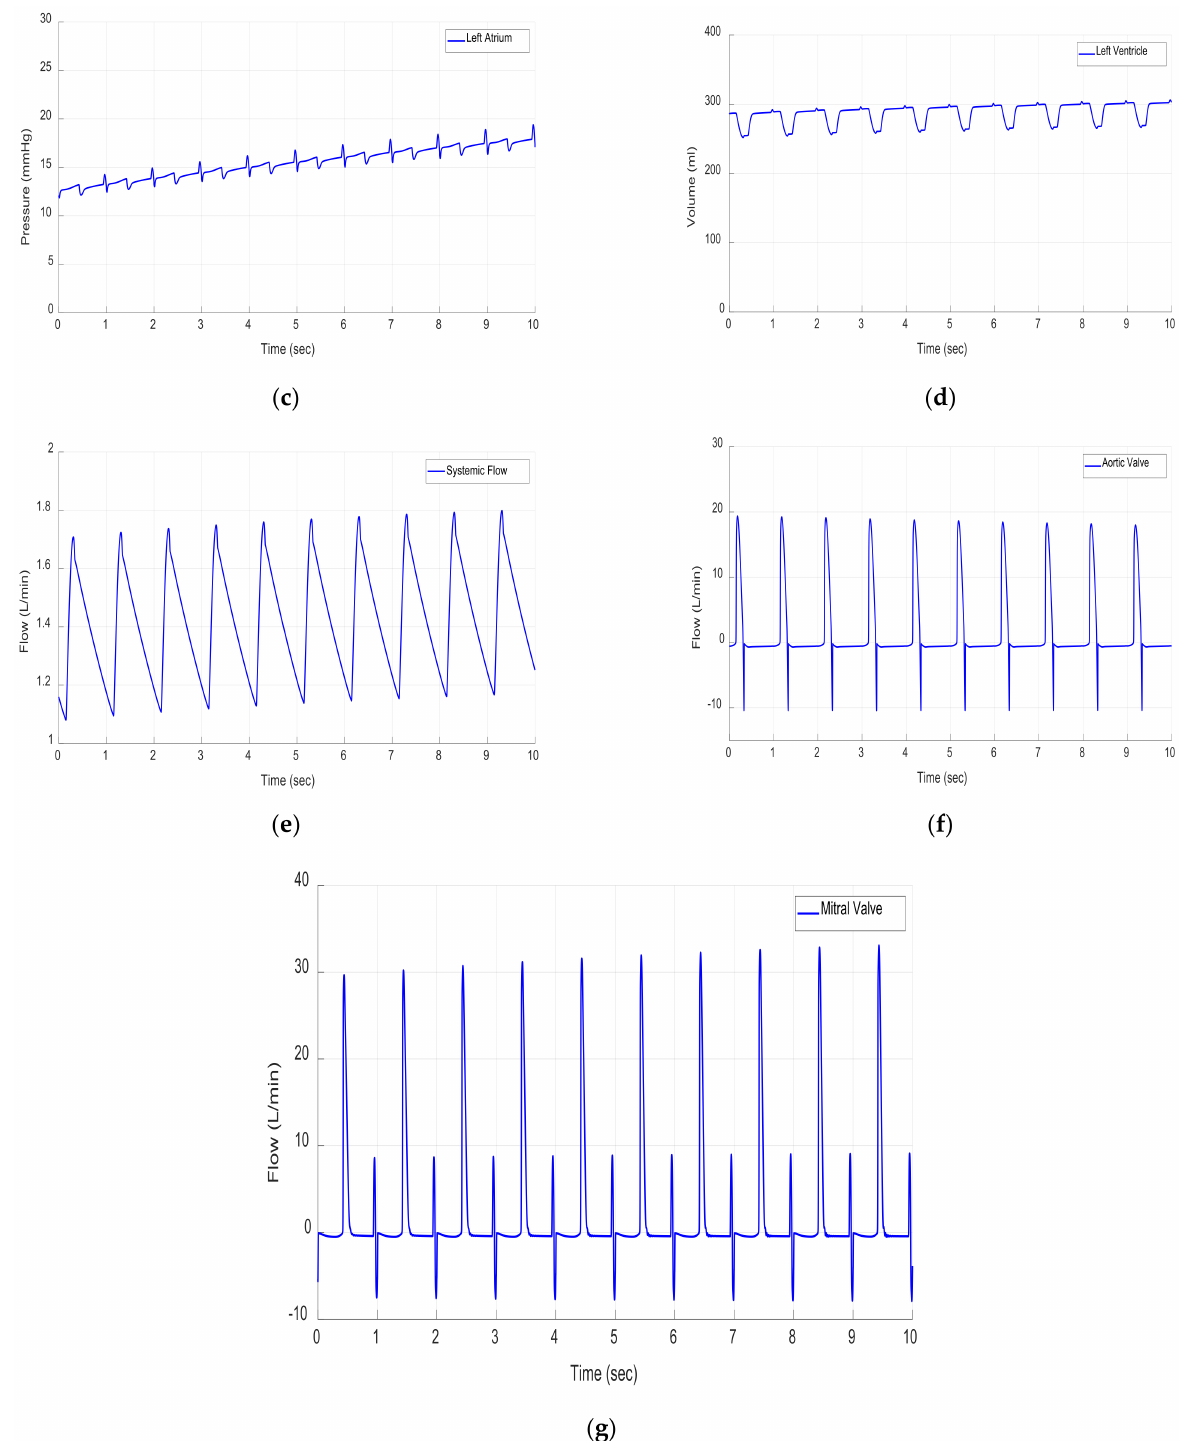
Figure 6. Hemodynamic variable results for a severe HF condition; ( a ) left ventricle pressure; ( b ) aortic pressure; ( c ) left atrium pressure; ( d ) left ventricle volume; ( e ) systemic flow; ( f ) aortic valve flow; ( g ) mitral valve